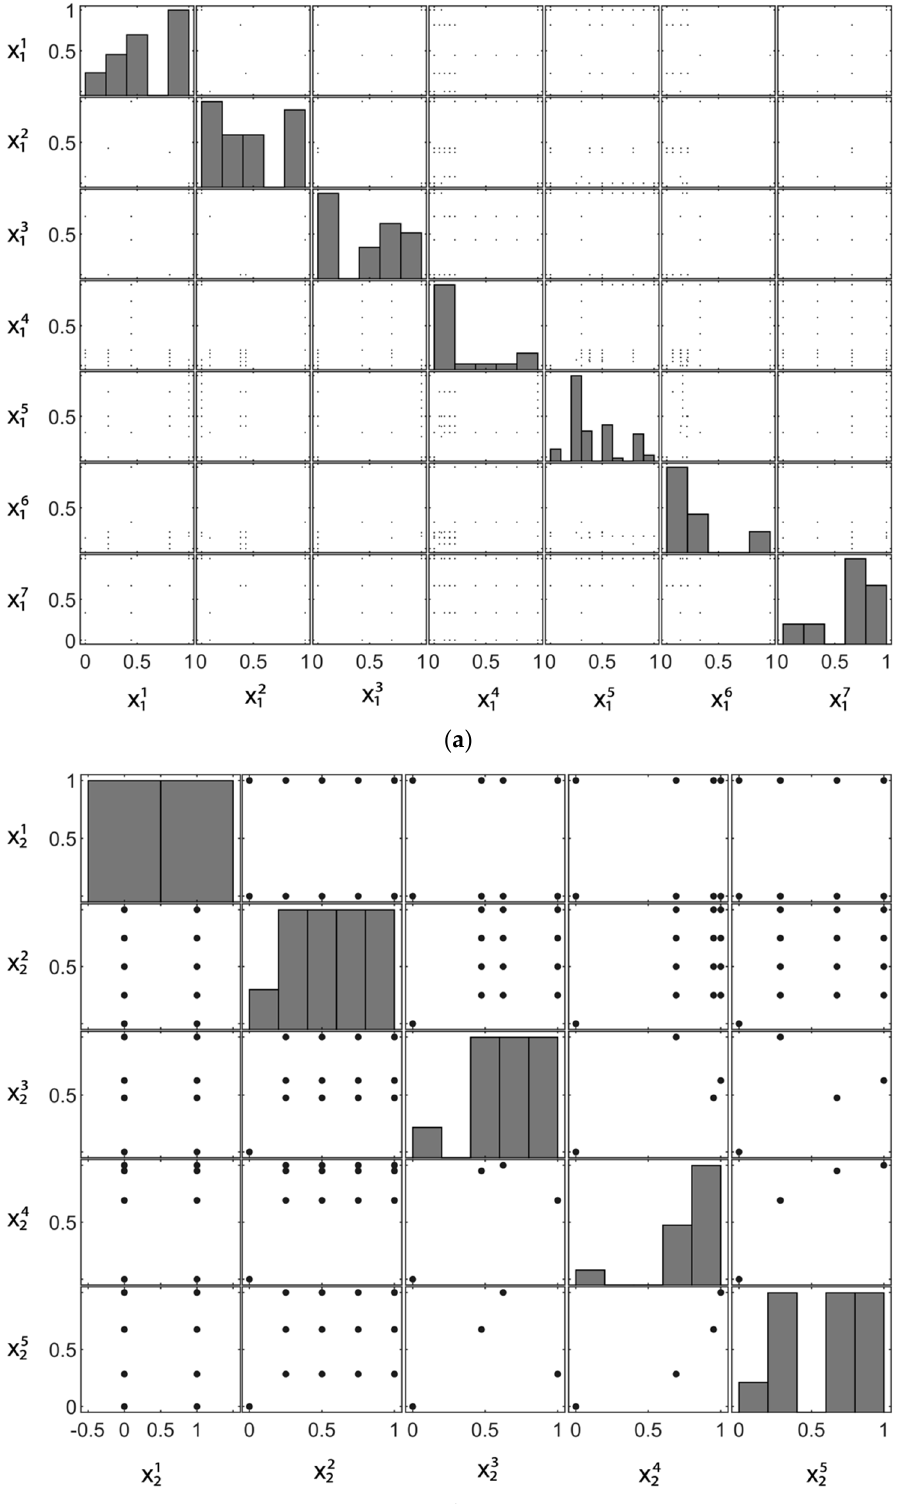
Figure 7. Scatterplot matrix: relationship between the normalised features of ( a ) Dataset 1 and ( b ) Dataset 2.